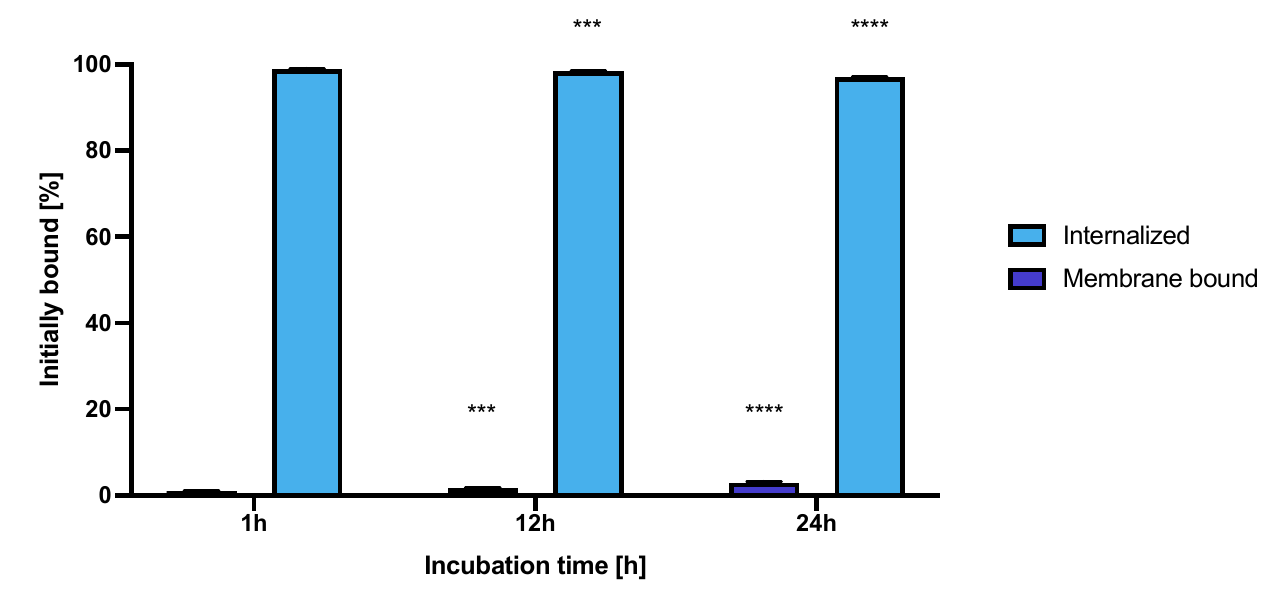
Figure 11. Internalization of NPs-Tmab on SKOV-3 (HER2+) observed after 1, 12 and 24 h of incubation with studied compounds. Data are expressed as mean value ± SD ( n = 3). Statistical confi- dence was considered if p < 0.001 (***), p < 0.0001 (****).